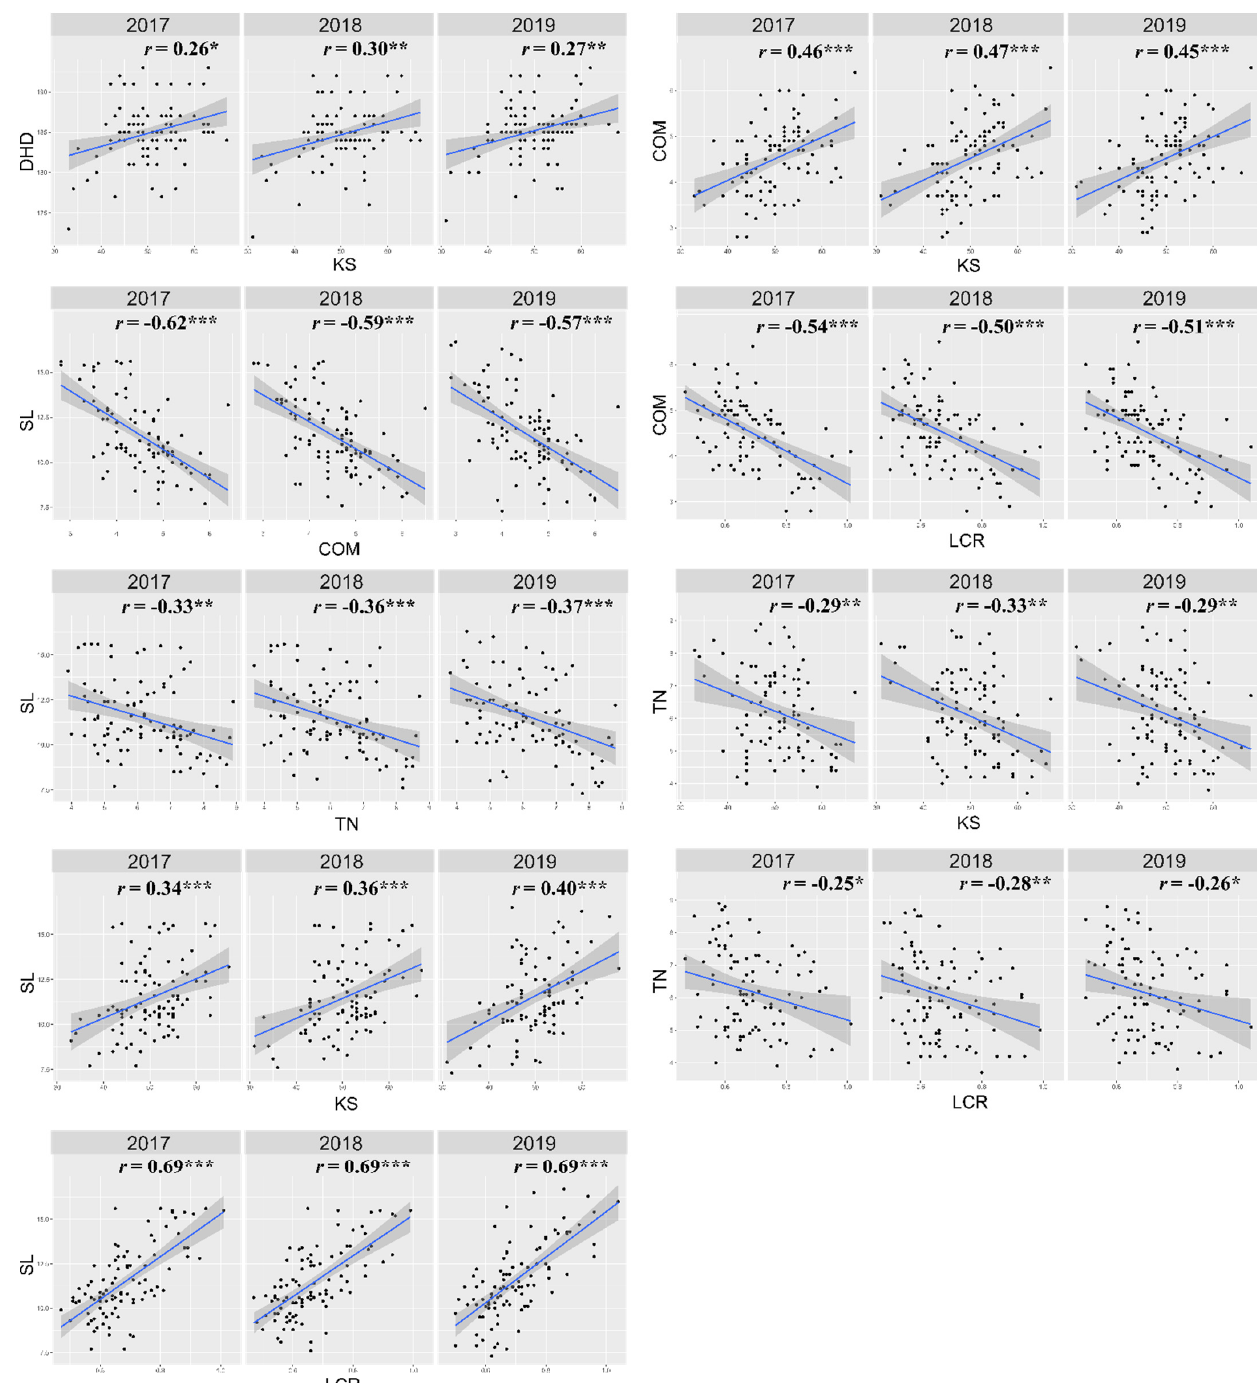
Figure 3. Correlation between yield potential traits in 94 F 10 recombinant inbred lines produced from the cross between Taejoong and Keumkang. DHD, days to heading date; CL, culm length; SL, spike length; COM, compactness; KS, kernels per spike; NS, number of spikes; LCR, length of center rachis. An asterisk indicates significance (*, **, and *** at P ≤ 0.05, P ≤ 0.01, and P ≤ 0.001 levels, respectively).